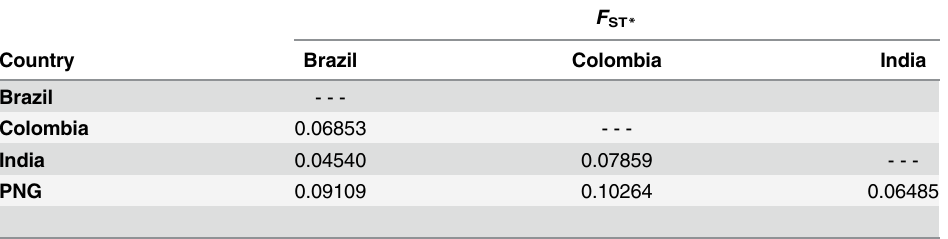
Table 2. Genetic distance ( F ST ) between P . vivax populations across study sites.